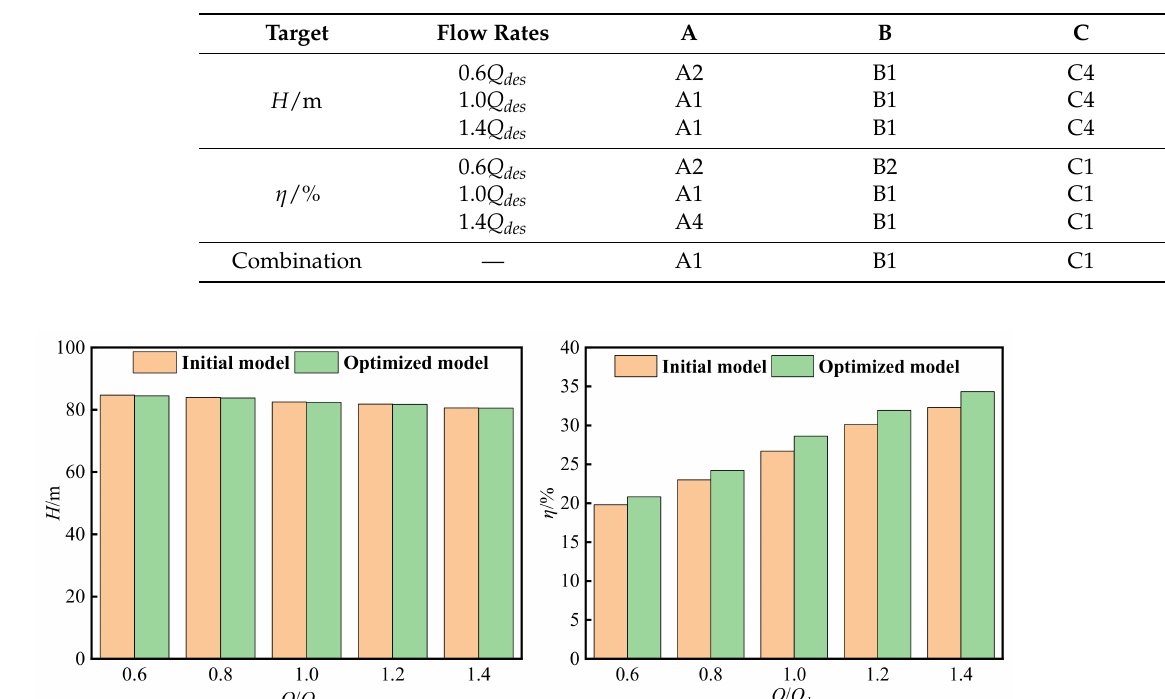
Table 12. Optimal parameter selection.